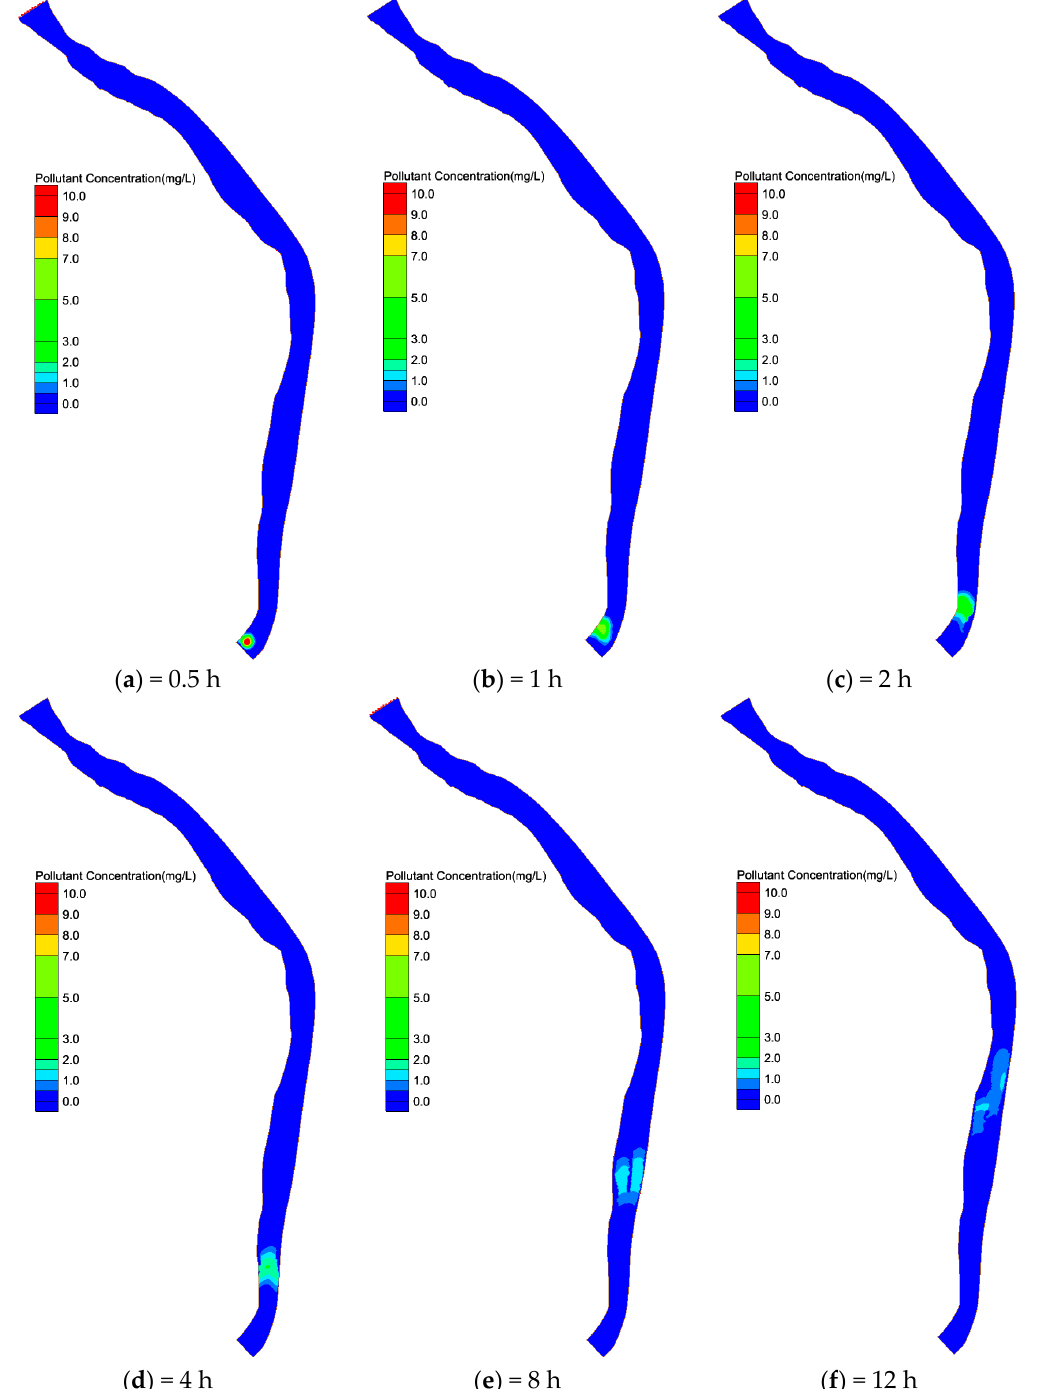
Figure 4. Pollution diffusion dynamics after the occurrence of the water pollution accident under Scenario A (Q = 2400 m 3 /s, H = 29.70 m).